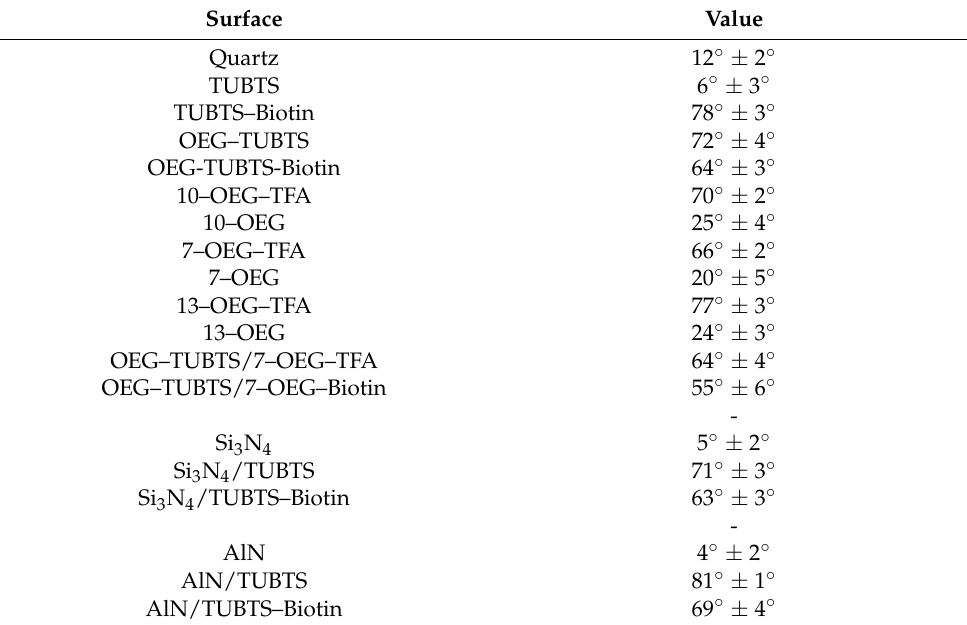
Table 1. Contact angle (CA) values for modified